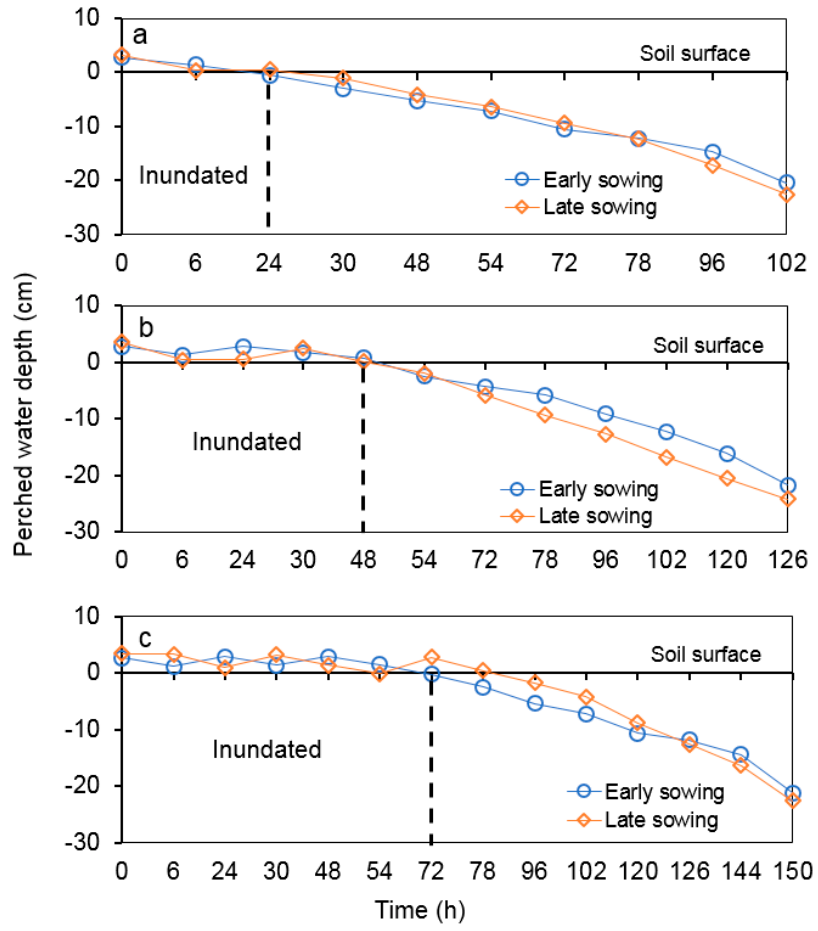
Figure 1. The dynamics of perched water depth above and below the soil surface during and following ( a ) 24 h, ( b ) 48 h and ( c ) 72 h of standing water in early and late sown sunflower. The left side of the dotted lines indicates the period when standing water was maintaining above the soil surface for each treatment and the right side indicates the waterlogging in the upper 30 cm of the soil profile [23].